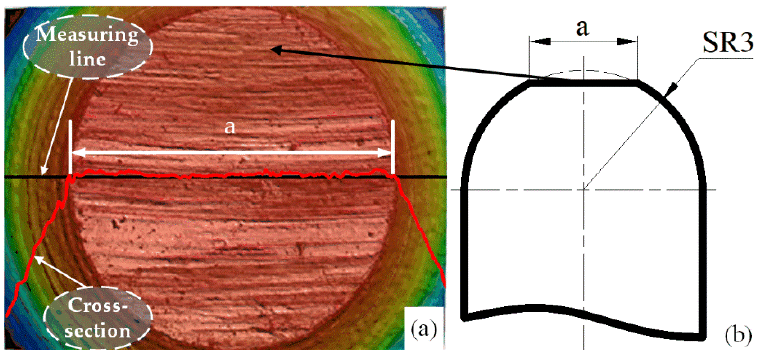
Figure 7. ( a ) Measurement schematic diagram. ( b ) Calculation schematic diagram.